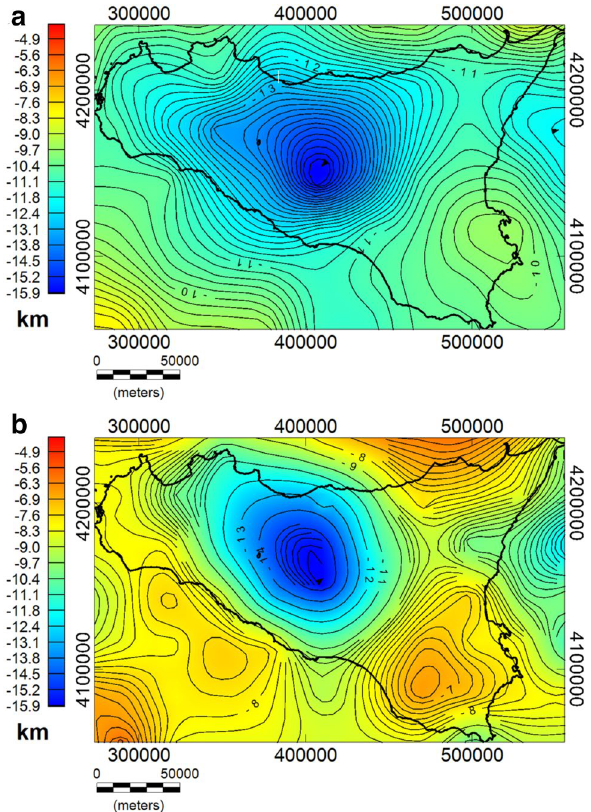
Figure 7. Maps of the crystalline top obtained from the spectral analysis of gravity ( a ) and magnetic ( b )